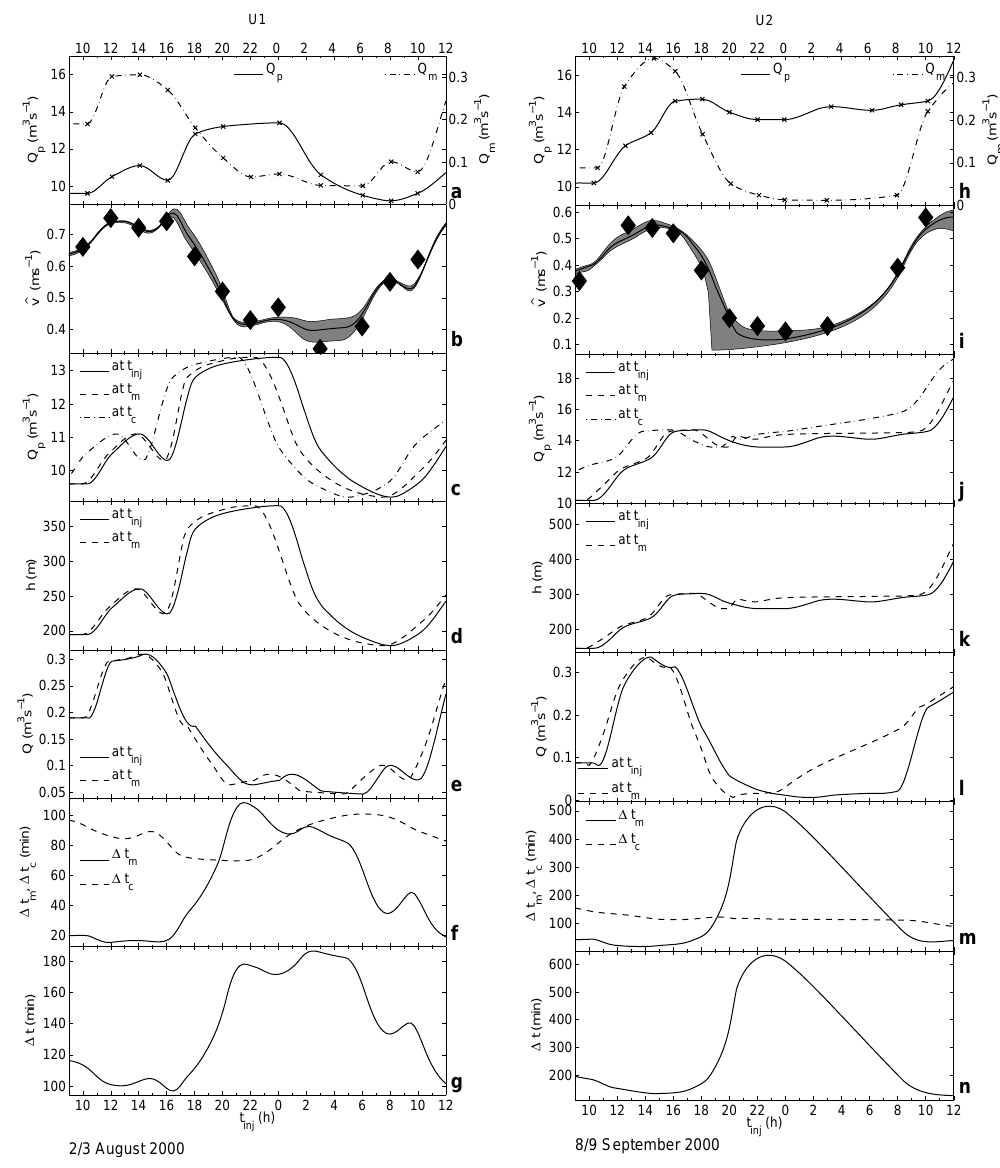
Fig. 6. Input, results and comparison to transit speed of the model fitted to the data from Unteraargletscher experiments in August (left, U1) and September 2000 (right, U2). The layout is identical to Fig. 5, except in (a) where crosses mark the measurements of Q p and Q m and the line is the